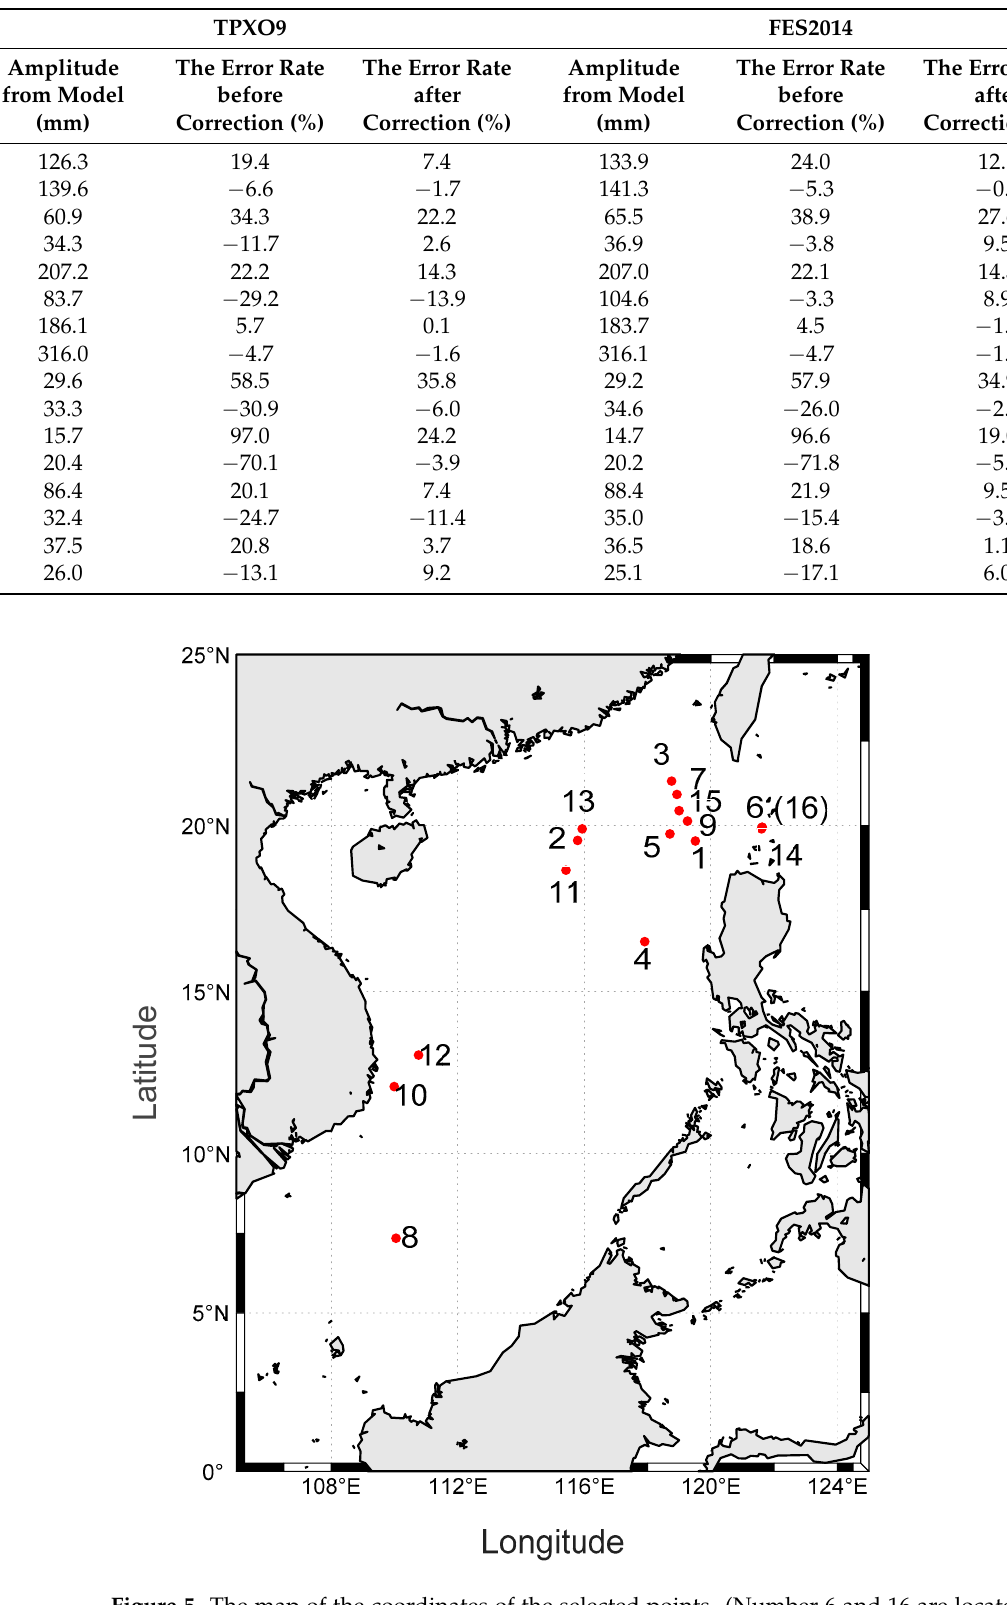
Table 6. The tidal amplitudes from TPXO9 and FES2014 models at selected points.